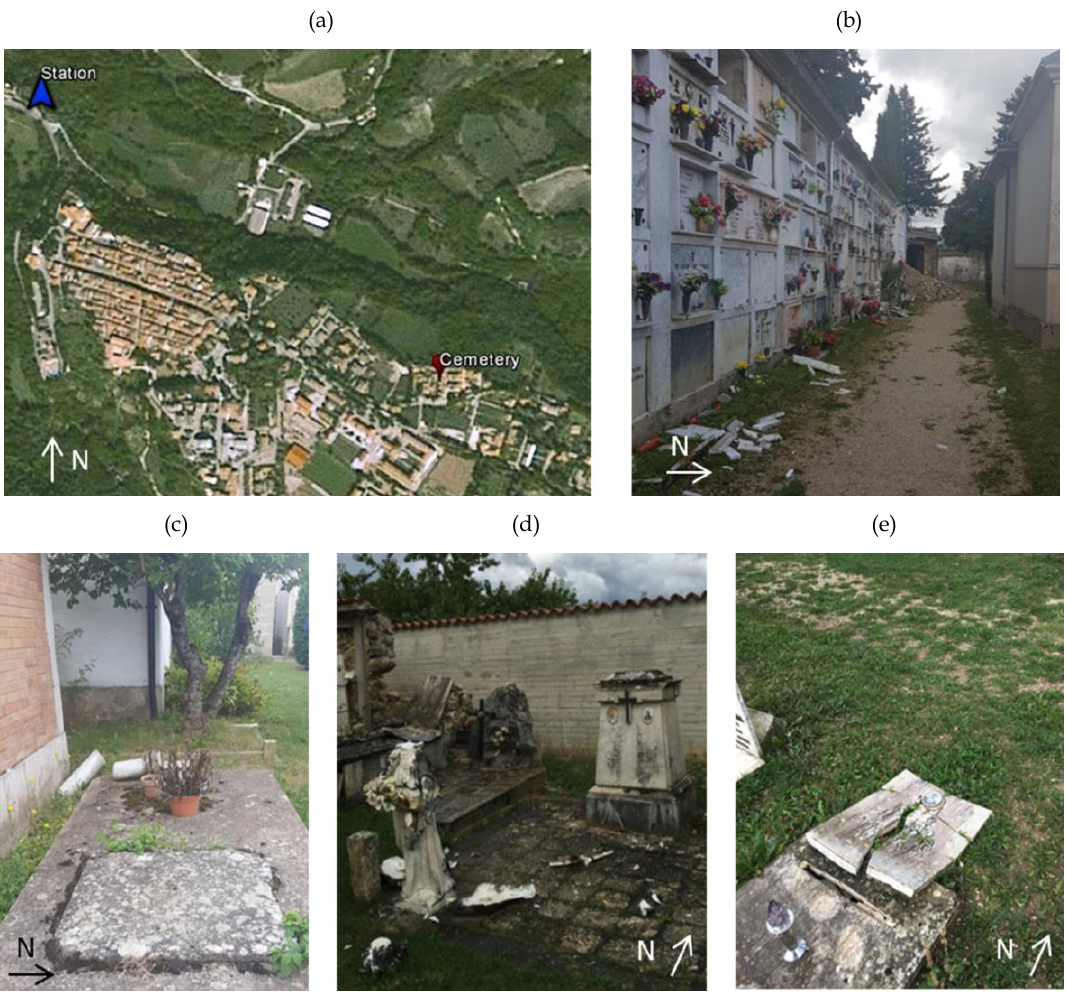
Figure 1. Location of the cemetery and of the seismic station at Amatrice (a), damages to statues, monuments and graves in the Amatrice cemetery